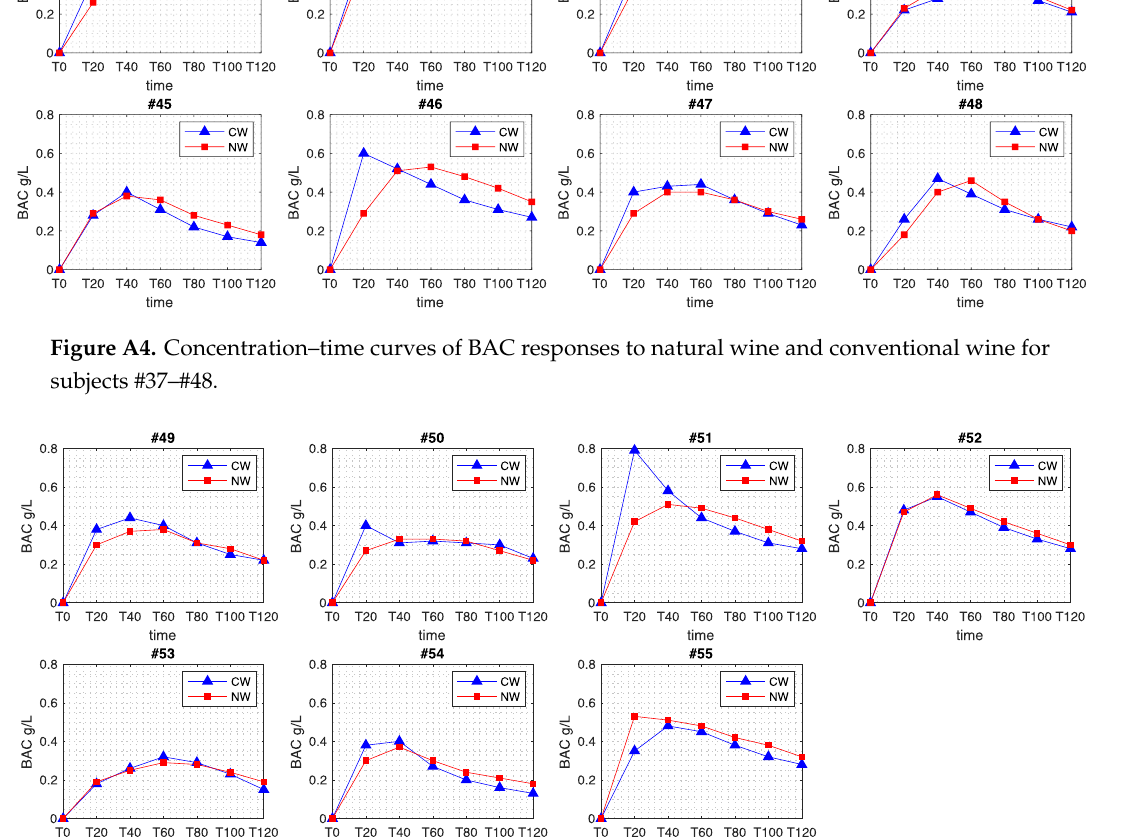
Figure A5. Concentration – time curves of BAC responses to natural wine and conventional wine for subjects #49 – #55.